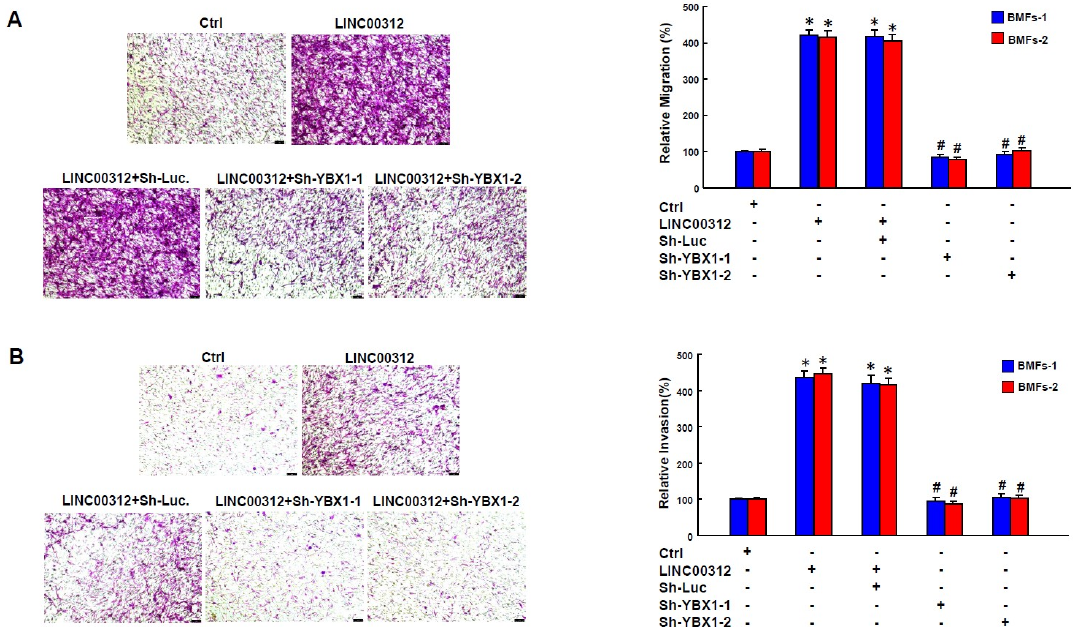
Figure 5. The knockdown of YBX1 reverses the LINC00312-increased migration and invasion capabilities in BMFs. Transwell migration ( A ) and invasion ( B ) of BMFs transfected with the indicated plasmids. Data were shown as the mean ± SD. * p < 0.05 compared to the control group. # p < 0.05 compared to the LINC00312+Sh-Luc group.